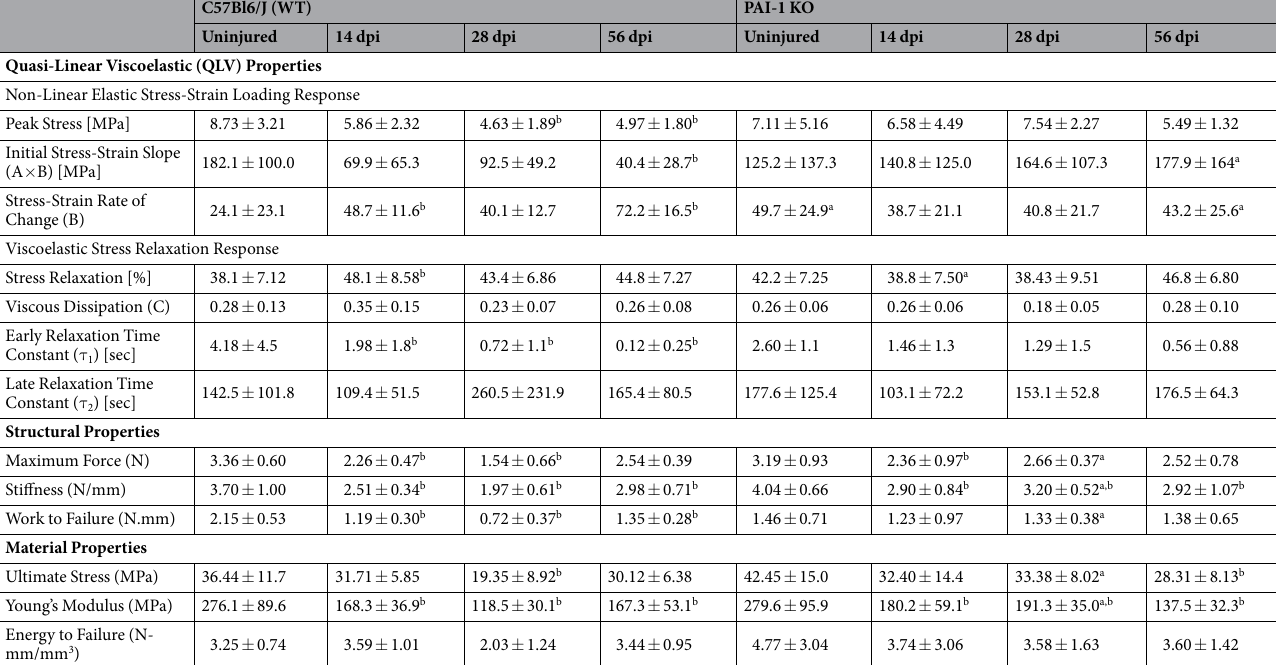
Table 1. Tensile Stress-Relaxation and Displacement-Controlled Tensile Failure Biomechanical Properties (mean ± SD). a Indicates significant differences from WT control at corresponding time point (p < 0.05). b Indicates significant differences from uninjured (p <